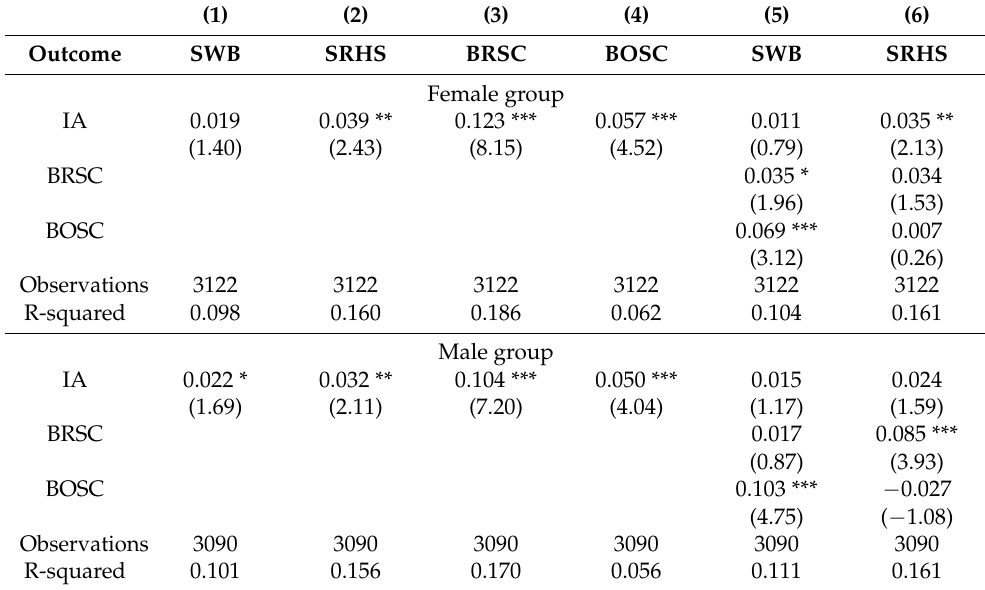
Table 5. Heterogeneous effect of